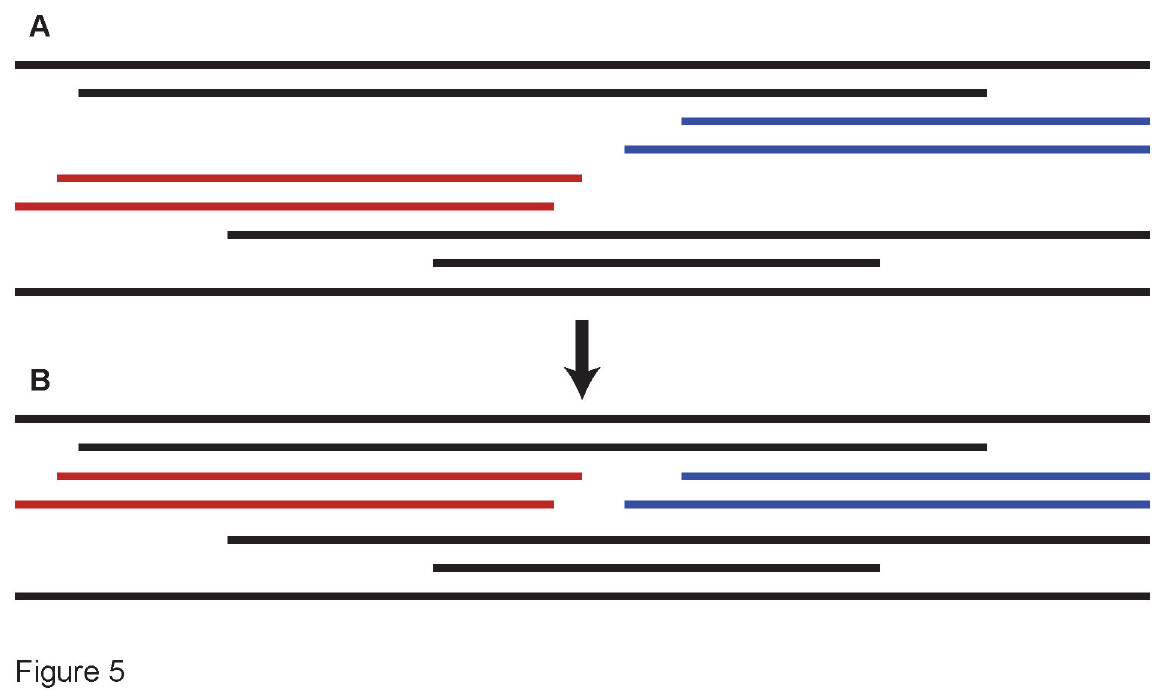
Figure 5. Example of our sequence-merging protocol. (A) In this schematic of a transcriptome alignment, aligned sequence fragments are indicated by the horizontal bars. Included are four fragments (colored) from our focal accession, which group together in the maximum parsimony tree. However, the two fragments from the 5’ end of the protein (in red) have some base pair conflicts with each other, as do the fragments from the 3’ end (in blue). Since the two sets of fragments do not overlap, and they group in the same area of the MP tree, it is not possible to determine which 5’ fragment belongs with which 3’ one. In this case we merged the sequences arbitrarily (B). The resulting alignment retains the full nucleotide data for primer-design purposes, but the relationships at the tips of the tree may be erroneous due to the two potentially chimaeric